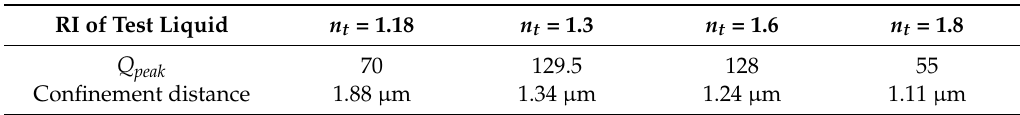
Table 1. Comparison between the Q -factor and the confinement distance between different test liquid filling the